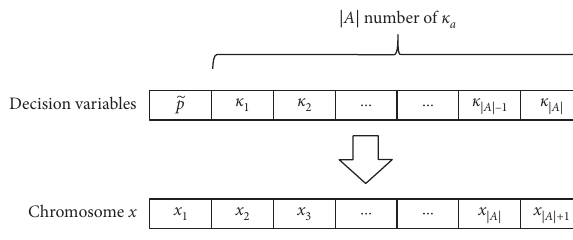
Figure 6: Flowchart of the genetic